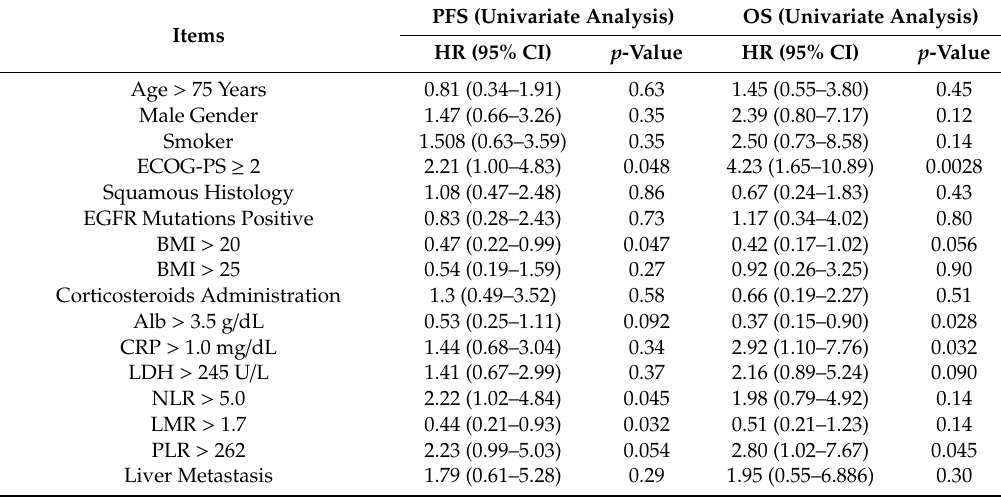
Table 2. Cox proportional hazards and logistic regression models for progression-free survival (PFS) and overall survival (OS) .